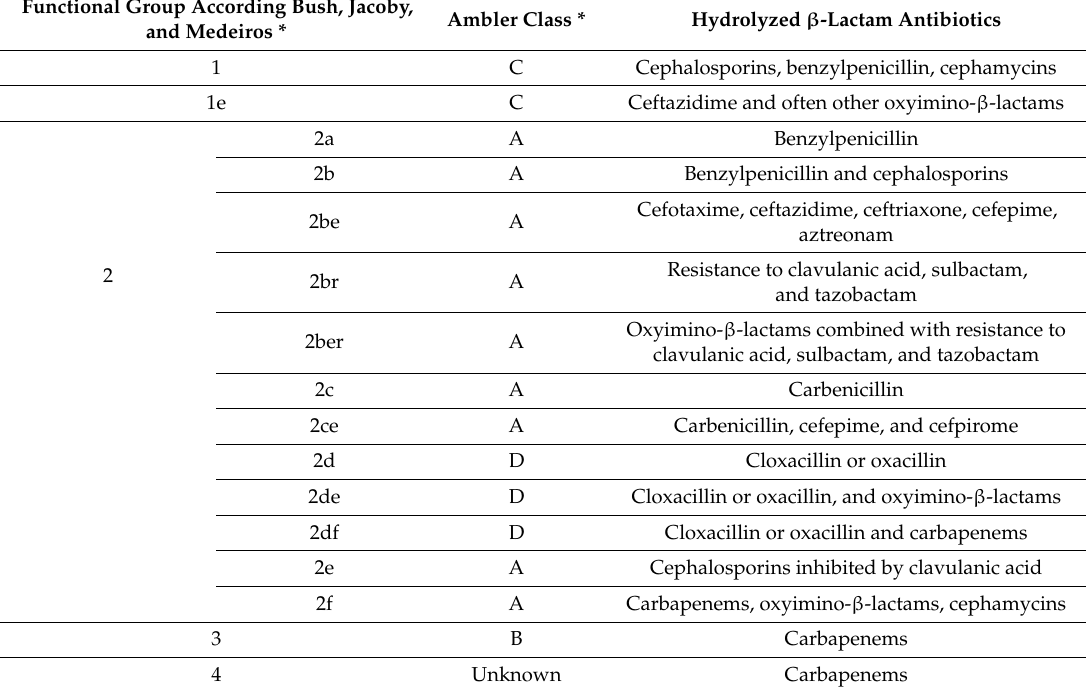
Table 1. Classification of β -lactamases based on Bush and Jacoby [44]. Functional Group According Bush, Jacoby, and Medeiros *